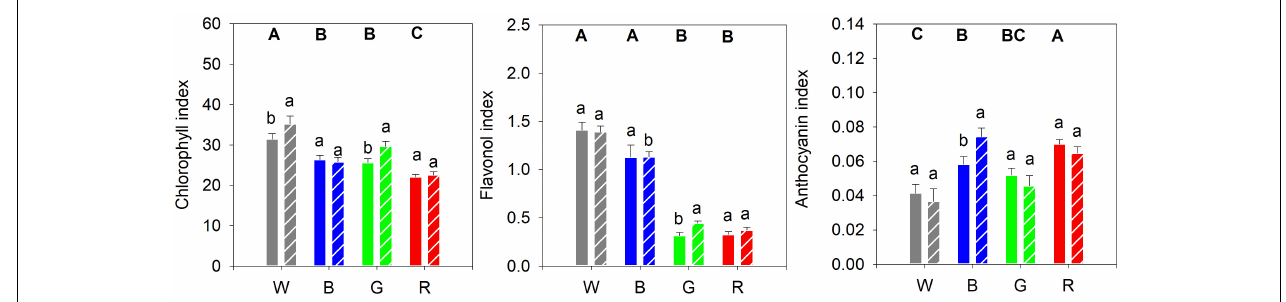
FIGURE 5 | (A) Epidermal chlorophyll, (B) flavonol and (C) anthocyanin content of cucumber plants, as measured with a DUALEX instrument, and grown under different light quality backgrounds (White, Blue, Green, and Red) and without (solid bars) or with (dashed bars) exposure to supplementary UV-B radiation for 14 days. Data are mean values ( n = 15 ± SE). Capital letters indicate significant differences between growth light qualities without UV-B and lower-case letters between non-UV-B-exposed plants and UV-B exposed plants within the same PAR background, both at P <